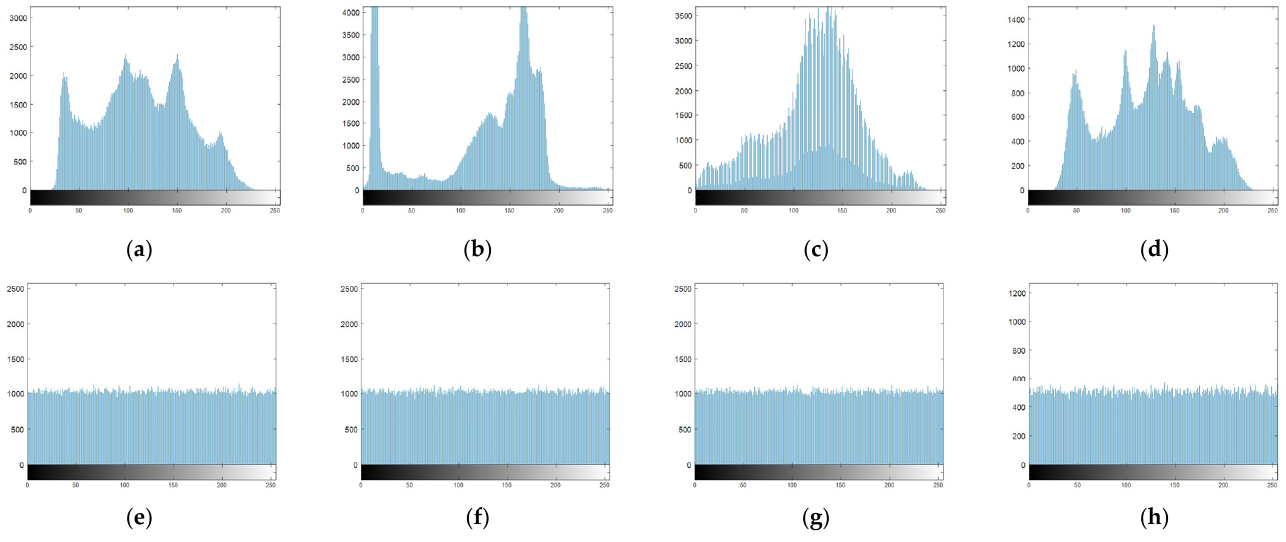
Figure 11. Histogram Analysis (256 ∗ 256): ( a – c ) original images; ( d – f ) encrypted image.